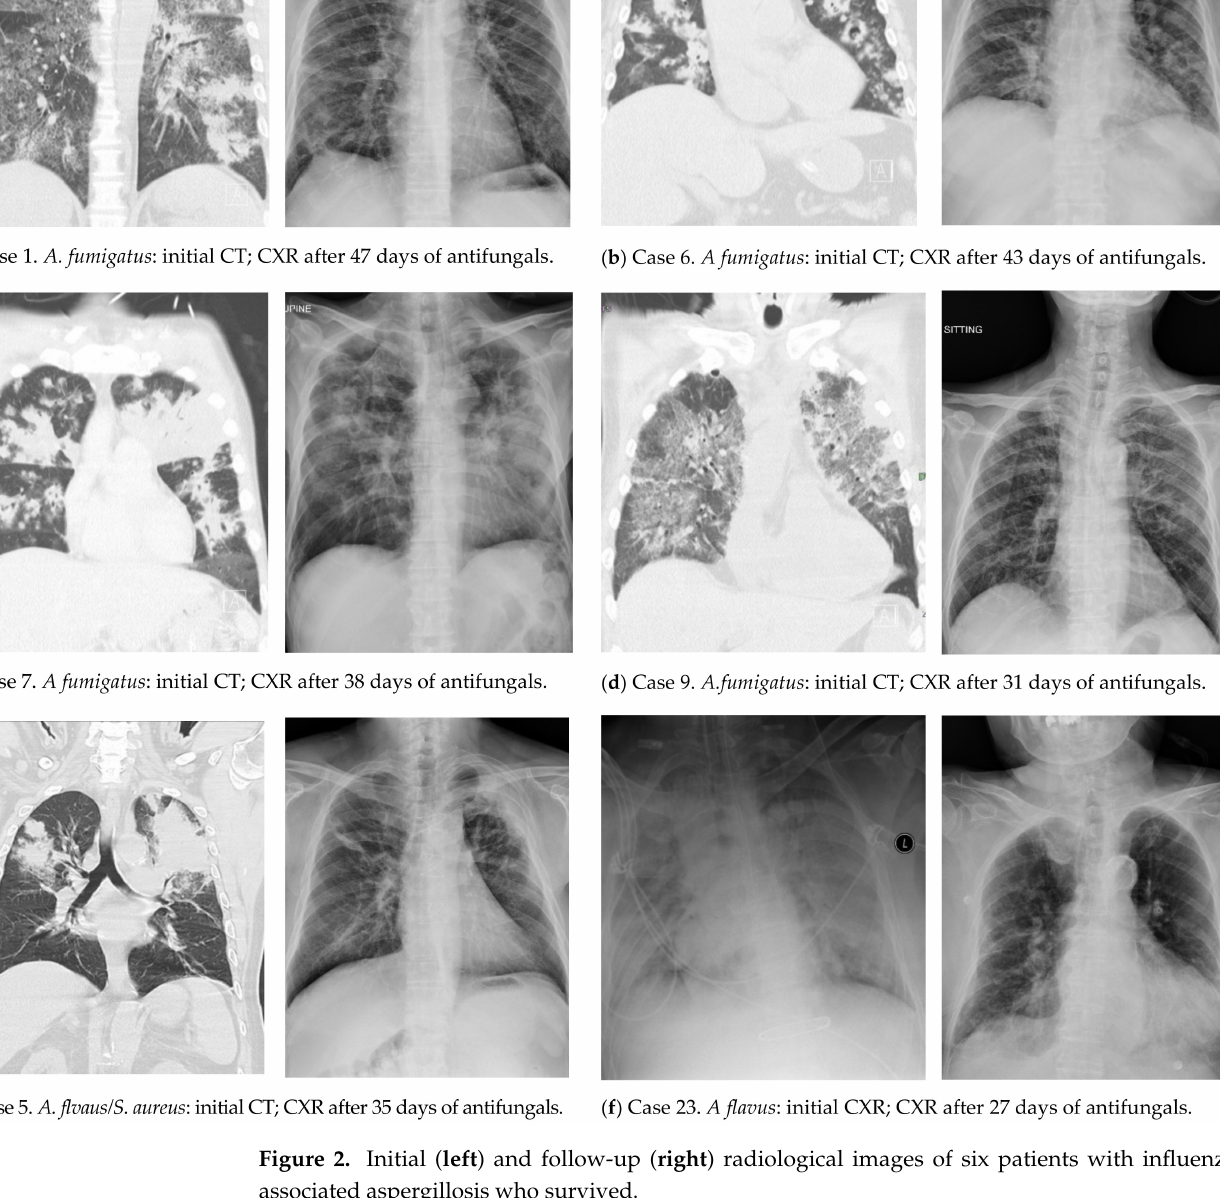
Figure 2. Initial ( left ) and follow-up ( right ) radiological images of six patients with influenza- associated aspergillosis who